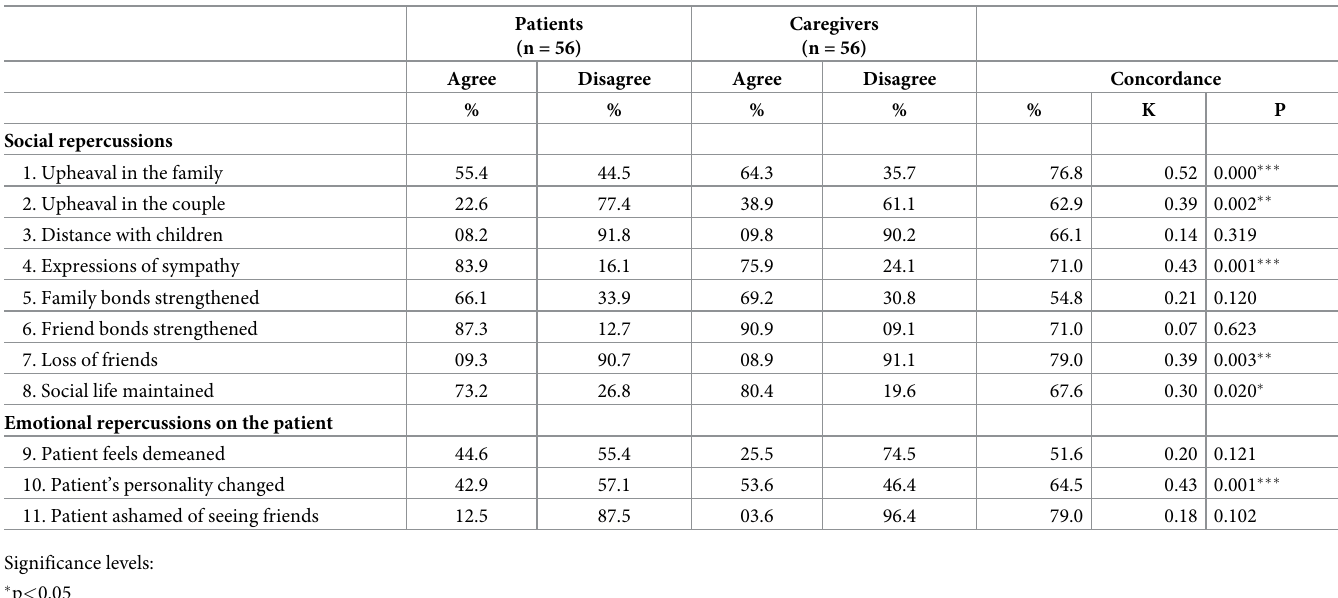
Table 2. Patients’ and caregivers’ attitudes towards stroke repercussions and dyad